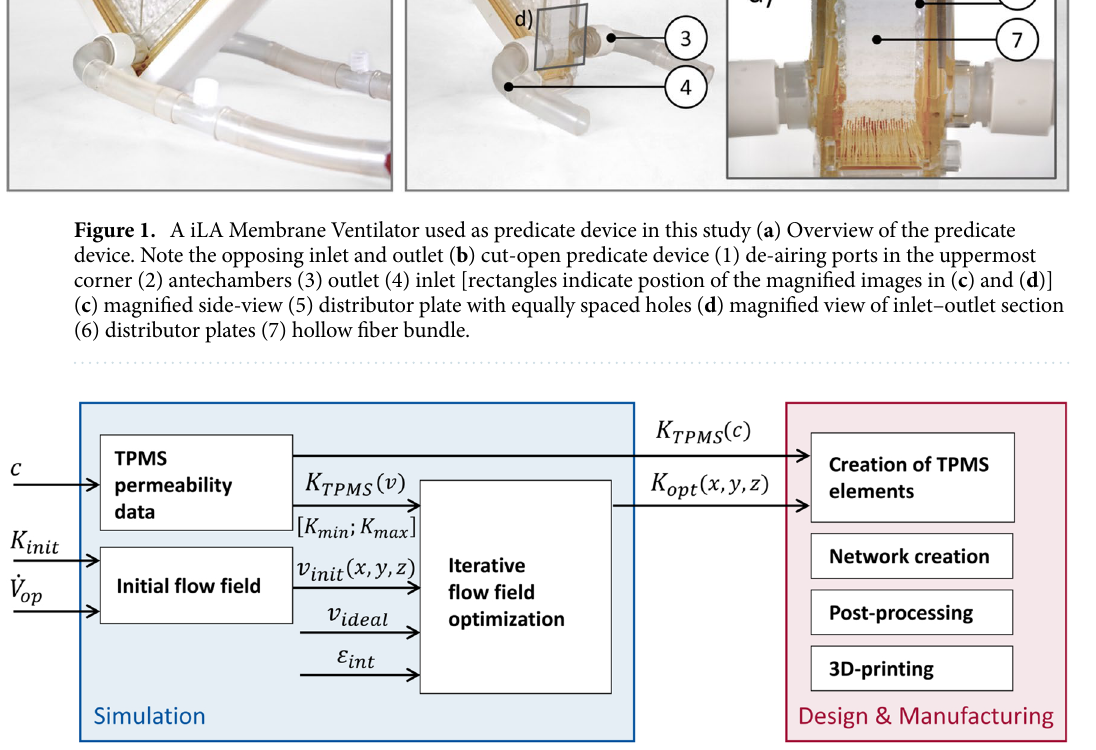
Figure 2. Schematic workflow used in this study for remodeling a predicate device towards optimized flow distribution based on TPMS membrane elements. In subsequent design and manufacturing, the geometric relation of the TPMS elements and their permeability K TPMS (c) is used for the translation of the optimized permeability field